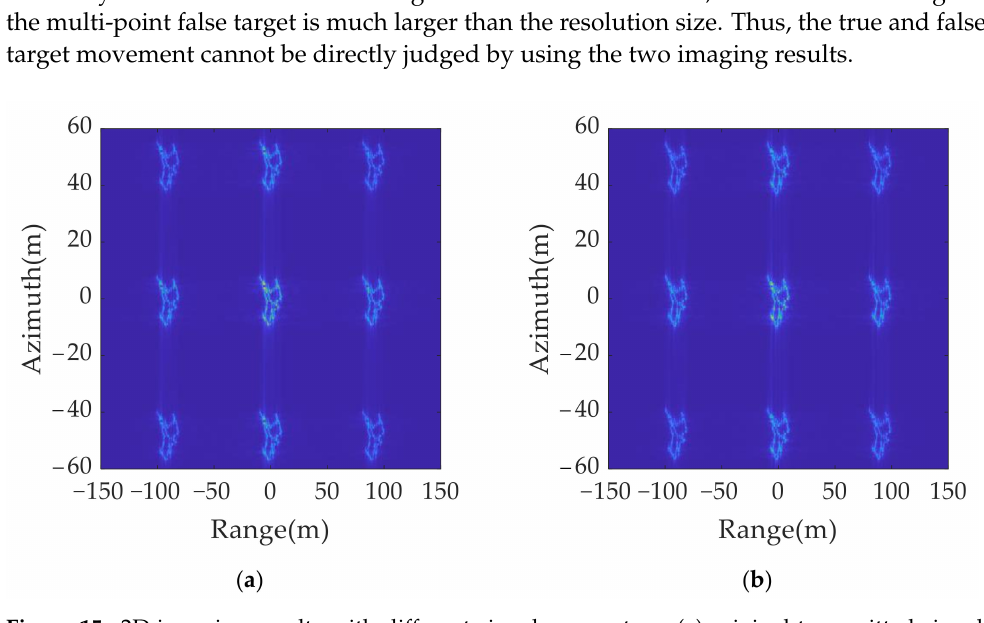
Figure 15. 2D jamming results with different signal parameters: ( a ) original transmitted signal; ( b ) anti-jamming twinning